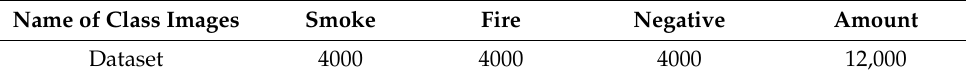
Table 1. Dataset information.